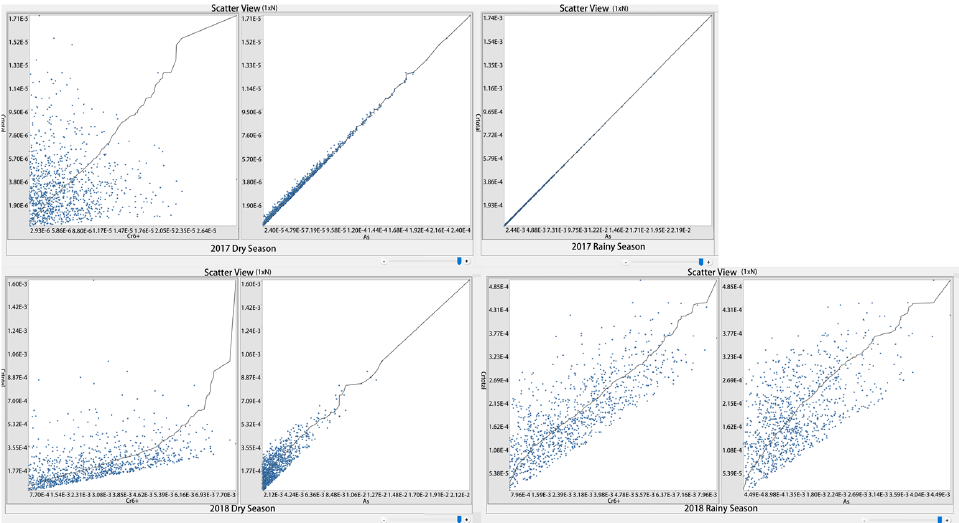
Figure 5. Association values for As and Cr.